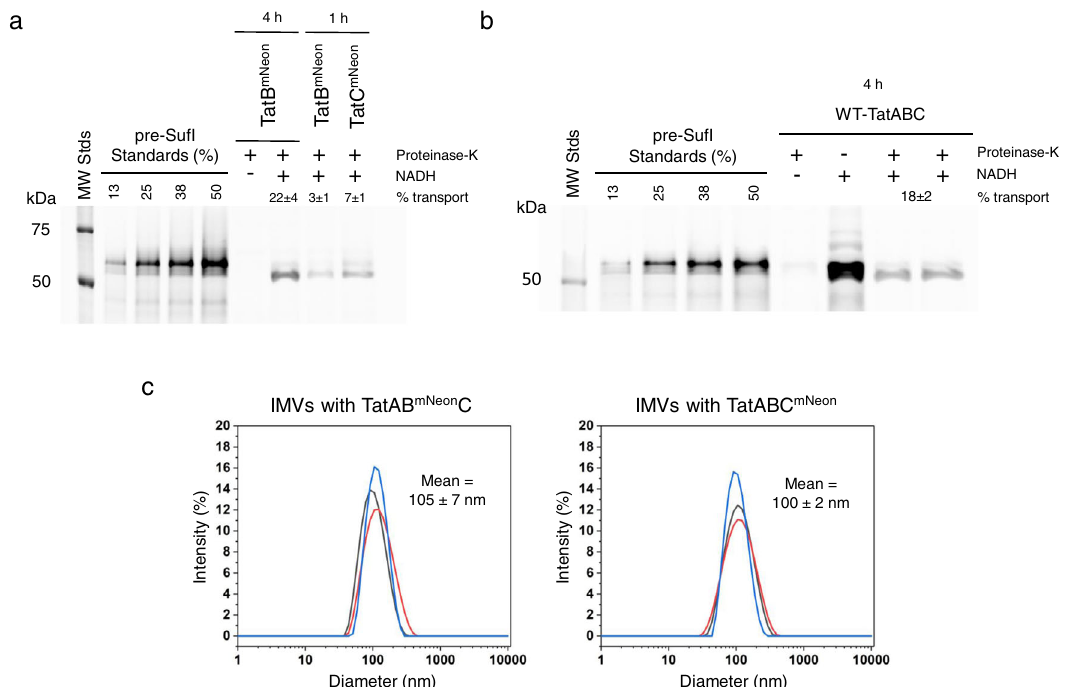
Fig. 2 Transport ef fi ciency and size of IMVs with TatAB mNeon C or TatABC mNeon . a , b In vitro transport assays. The amount of SufI(IAC) Alexa647 (50 nM) transported into Tat ++ IMVs was determined after 20 min at 37 °C. Transport ef fi ciency (% transport) was estimated from the amount of protease- protected mature-length protein compared with the amount of total added precursor protein (pre-SufI standards). The necessary pmf was generated by the addition of NADH (4 mM). A 4 h induction period yielded a similar transport ef fi ciency for TatAB mNeon C ( a ) and wildtype TatABC (Tat ++ ) IMVs ( b ). SDS-PAGE gels were analyzed by direct in-gel fl uorescence imaging ( λ ex = 488 nm). A substantially lower transport ef fi ciency was observed for a short (1 h) overproduction time ( a ), which was required to ensure a low number of Tat receptor complexes per IMV. All transport ef fi ciencies were calculated from duplicate assays. c IMV size. Diameter distributions of three independent preparations of IMVs containing either TatAB mNeon C or TatABC mNeon , as determined by DLS. A consistent average diameter of ~100 nm was